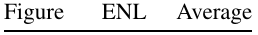
Table 1. Estimates of the equivalent number of looks for both images from Figure 2. Figure